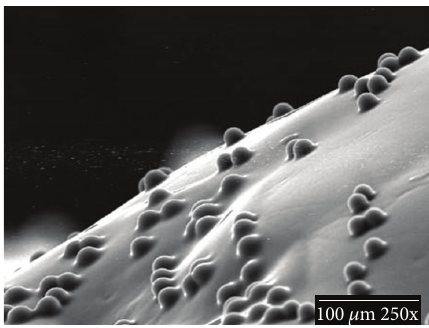
Figure 4: The hand-held imaging unit is about 6 inches wide and 8 inches deep. The white button activates the blue lights and red lasers, both of which are blocked by the green bandpass filter and are not imaged. The red button is for